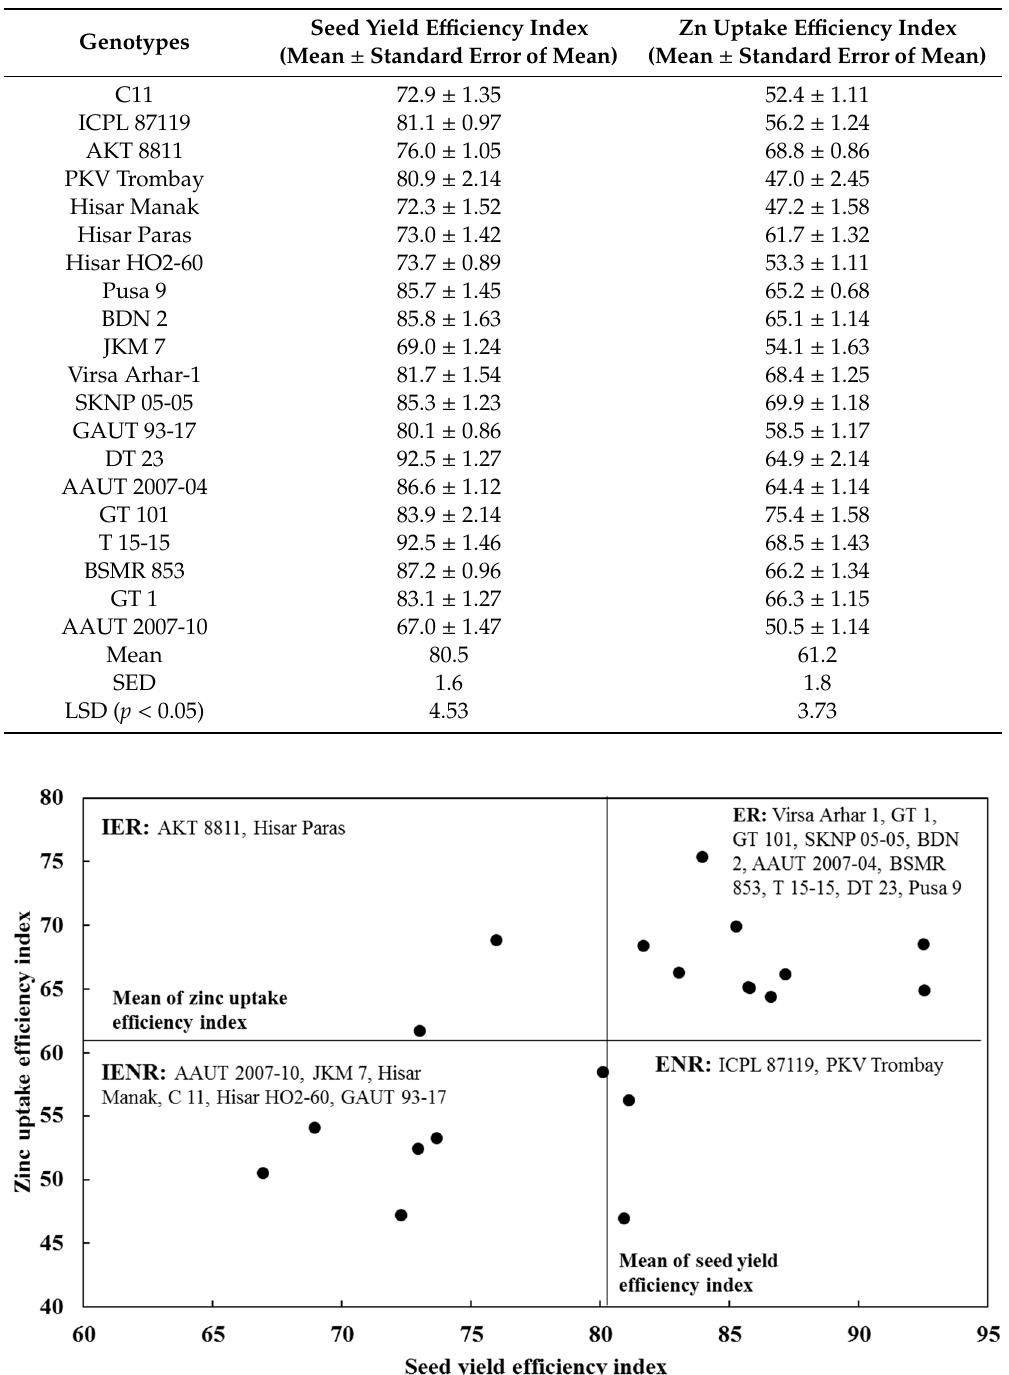
Table 5. Seed yield e ffi ciency index (SYEI) and zinc (Zn) uptake e ffi ciency index (ZUEI) of pigeonpea genotypes. SED = standard error of di ff erence; LSD = least significant di ff erence.